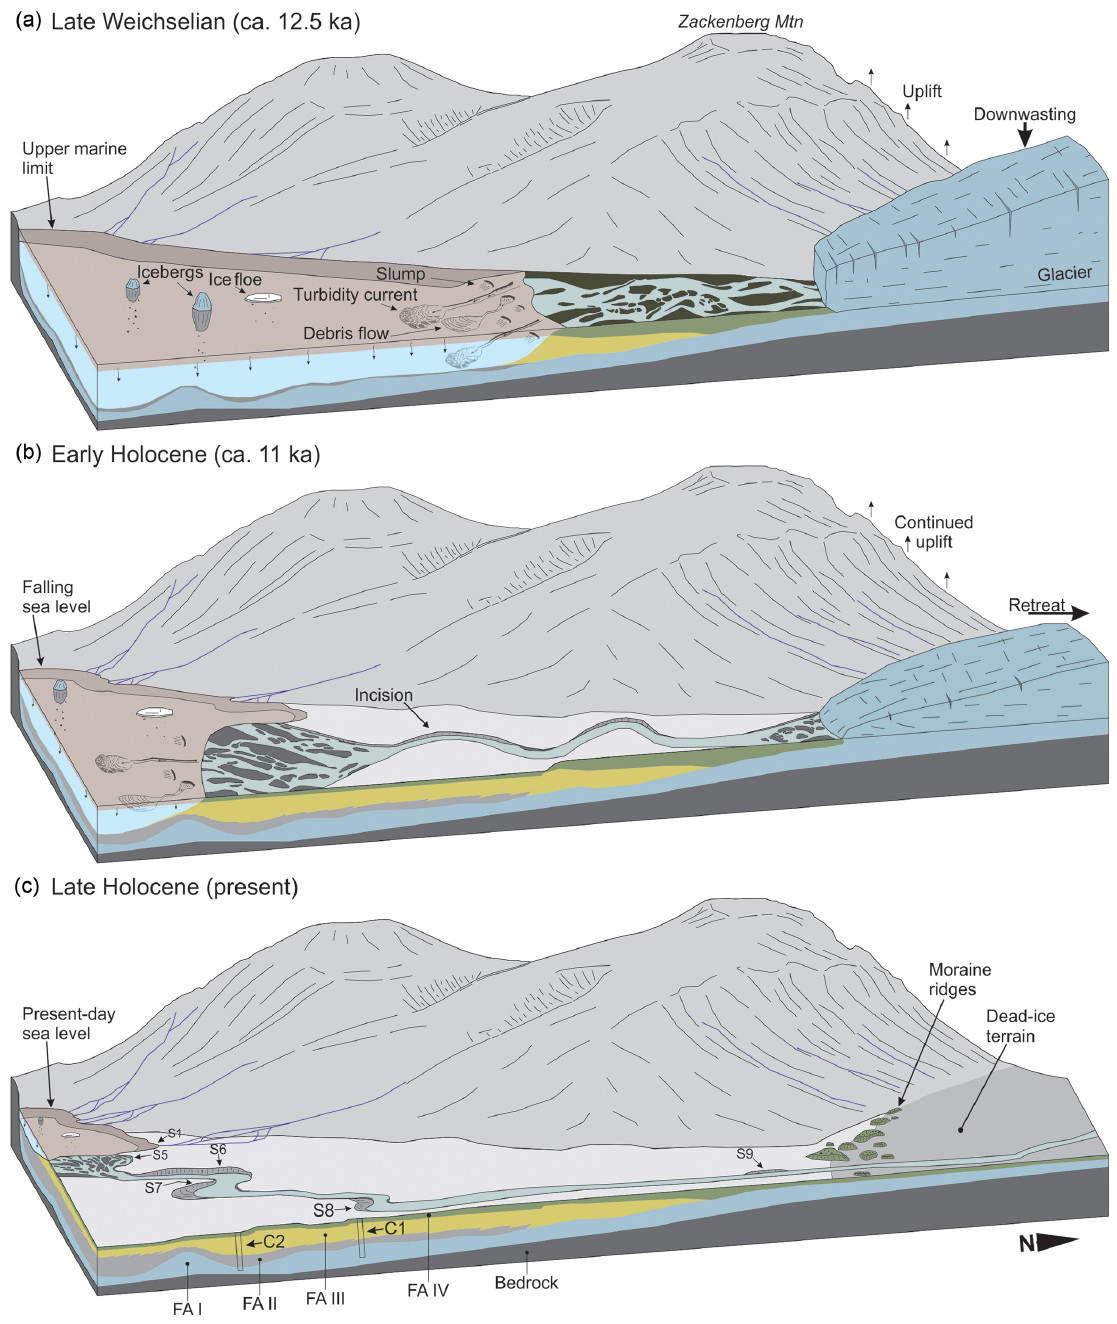
Figure 9. Schematic model of the three main stages of landscape development of the Zackenberg River delta and adjacent lowlands. The model illustrates the essential processes and sediment sources which contributed to the development of the valley-fill deposits. (a) Late Weichselian deglaciation and inundation. Sediment was supplied by a proximal glacier and by mobilization of glacial deposits by contempo- rary fluvial networks. (b) Early Holocene sea-level fall and areal deglaciation. High sedimentation rates and rapid delta progradation during sea-level fall. Sediment supplied primarily through the reworking of deposits by glaciofluvial erosion and incision during isostatic uplift. The landscape is slowly dissected by a meandering braided-river system resulting in the terracing observed in the landscape today. Locally, permafrost began to aggrade in the lowlands following subaerial exposure. (c) Modern landscape with select sections and coring locations. Sediment supplied by the fluvial reworking of raised deposits. Permafrost is continuous under stable, exposed land surfaces.